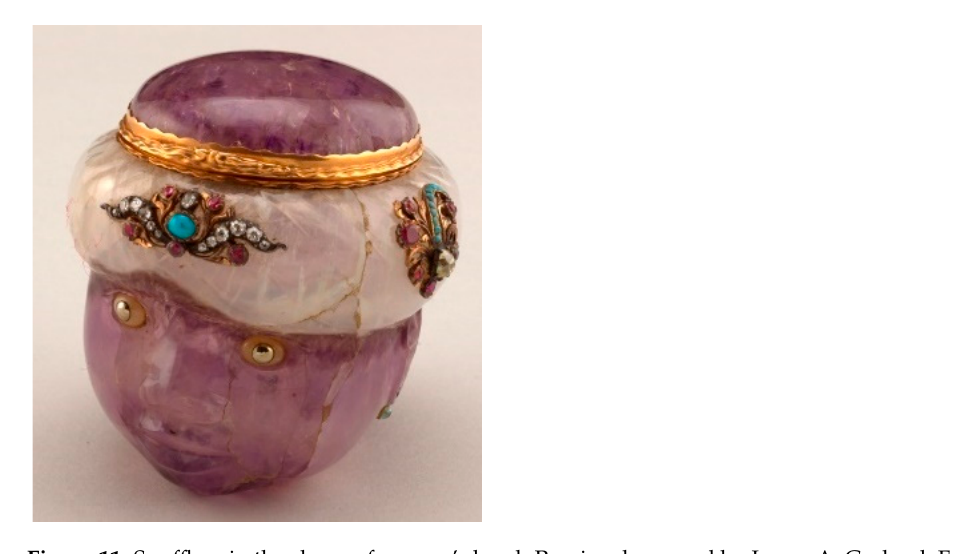
Figure 11. Snuffbox in the shape of a moor’s head. Previously owned by James A. Garland; France; amethyst, gold, silver, cut diamonds, rubies, emeralds, turquoise, moonstone, platinum, (1967-48-19). Cooper-Hewitt Museum. Public domain.